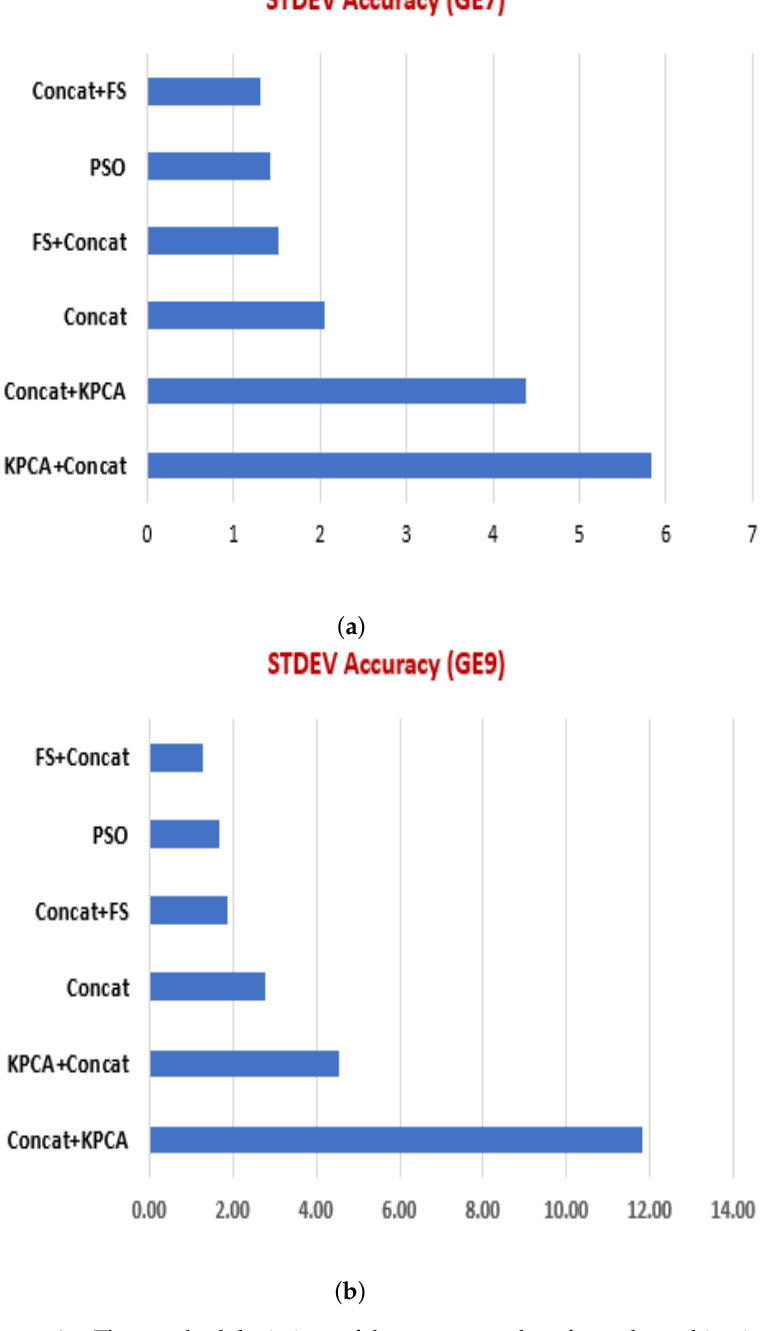
Figure A1. The standard deviations of the accuracy values for each combination scheme: ( a ) for the GE7 dataset; ( b ) for the GE9